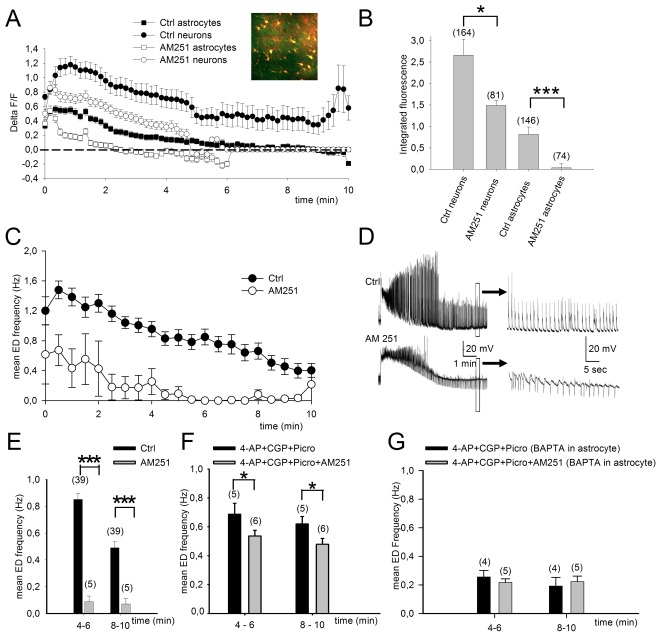
CB1 receptors expressed by astrocytes contribute significantly to maintenance of ED in CA1.A, Two-photon fluorescence calcium imaging of CA1 cells during 4-AP perfusion of the slice. Fluorescence signals from neurons and astrocytes during 4-AP in the presence or absence of the CB1 receptor antagonist AM251 (4 µM). The plotted points represent the averages of the responses for each individual cell. B, Blocking CB1 receptors significantly reduced integrated area of calcium induced fluorescence measured 1–4 min after ED initiation. This inhibition was markedly particularly important in astrocytes (p<0.001 Mann-Whitney U test) C, Similarly, average time course show that ED in CA1 pyramidal cells recorded in current-clamp mode is reduced in the presence of the CB1 antagonist AM251. D, Representative traces for data shown in C. E, Mean ED frequency at two time points after initiation of ED for CA1 pyramidal cells show that the reduction induced by AM251 is highly significant. F, In the presence of GABAA and GABAB receptor antagonists to block interneuron signaling, blocking CB1 receptors still results in a significant reduction in ED but much less effective in reducing ED frequency. G, When astrocyte signaling is inhibited by BAPTA injection (40 mM) under conditions where GABAergic transmission is blocked, the blockade of CB1 receptors no longer reduces 4-AP-induced ED.